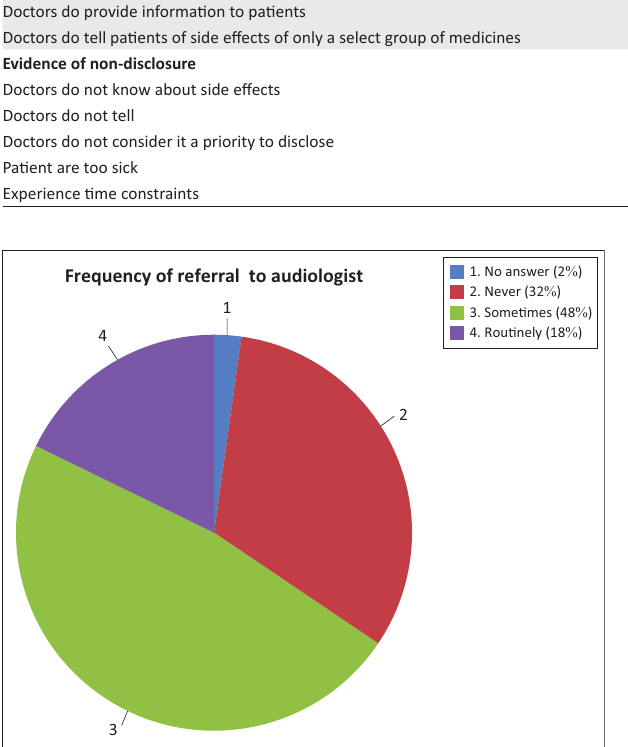
FIGURE 6: Frequency of referral to audiologists in the management of